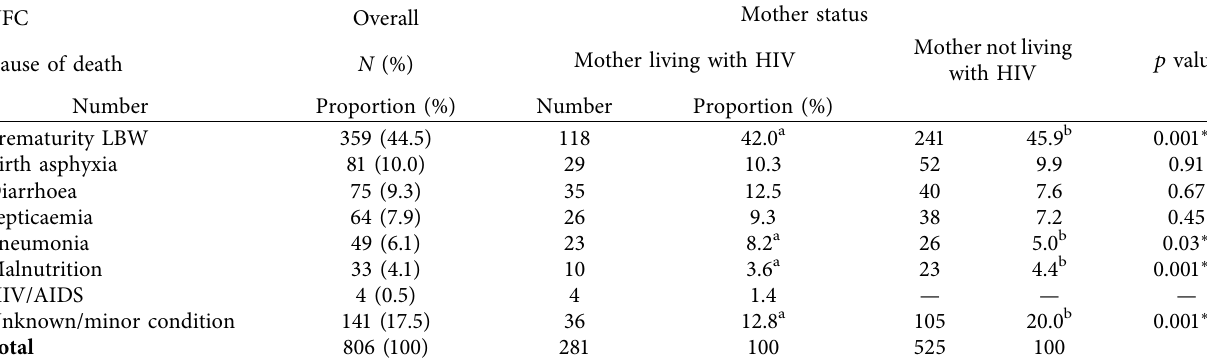
UFC � under-five children, LBW � low birth weight, and ∗ p < 0 . 05; ∗∗ p < 0 . 001; different letters between rows reflect significant differences ( p < 0 . 05).